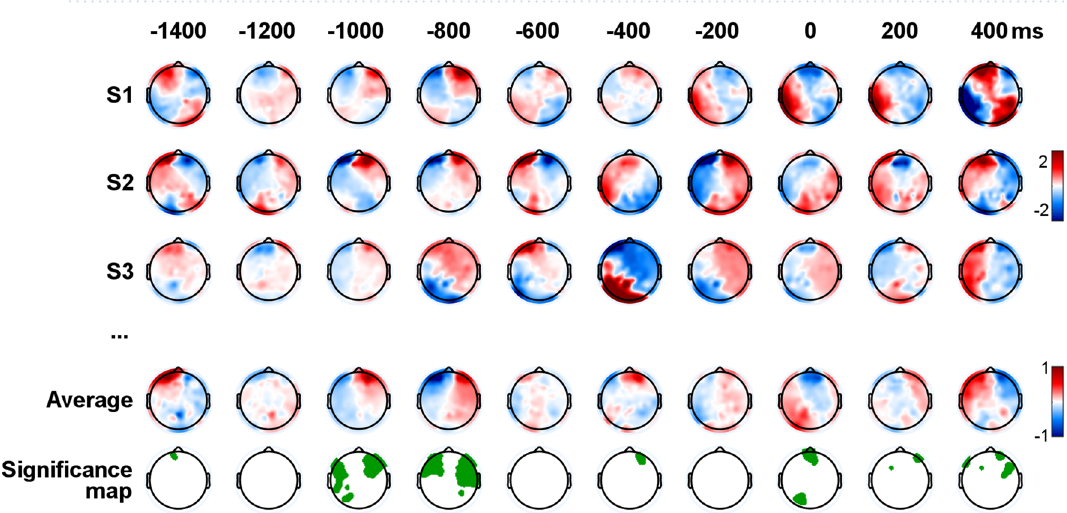
Figure 2. Significant EEG signals anticipate steering actions. LLR encoding models describing the EEG dynamics that precede and follow steering actions. Colours indicate LLR regression weights for individual participants and the average model. The bottom row shows electrodes with weights significantly different from zero ( p < 0.05, FDR-corrected Wilcoxon test across